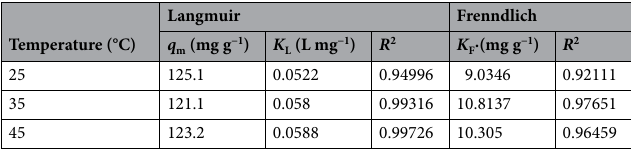
Table 3. Langmuir and Freundlich isothermal equation parameters.